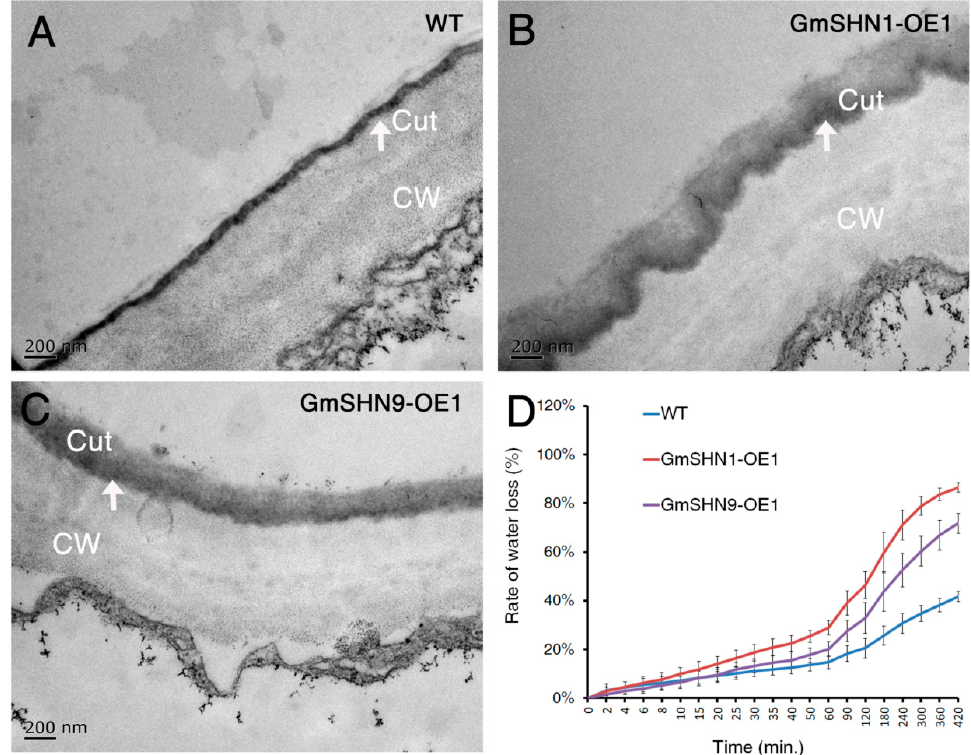
Figure 9. TEM ultrastructure of cuticle layer and rate of water loss. ( A – C ) TEM images of 4-week-old leaf epidermal cell sections of GmSHN1-OE1, GmSHN9-OE1, and WT. A thicker but loosely packed layer of electro dense material (the arrows) can be observed in GmSHN1-OE1 and GmSHN9-OE1 epidermal cells. Cuticle layers were shown by arrows. Cut, cuticle layer; CW, cell wall; Scale bars, 200 nm; ( D ) Rate of water loss of 4-week-old dark-adapted Arabidopsis rosette tissues of GmSHN1-OE1, GmSHN9-OE1, and WT. Four rosette tissues (root detached) were weighed at each time. The results are the mean values of three independent assays, and error bars indicate ±SD.